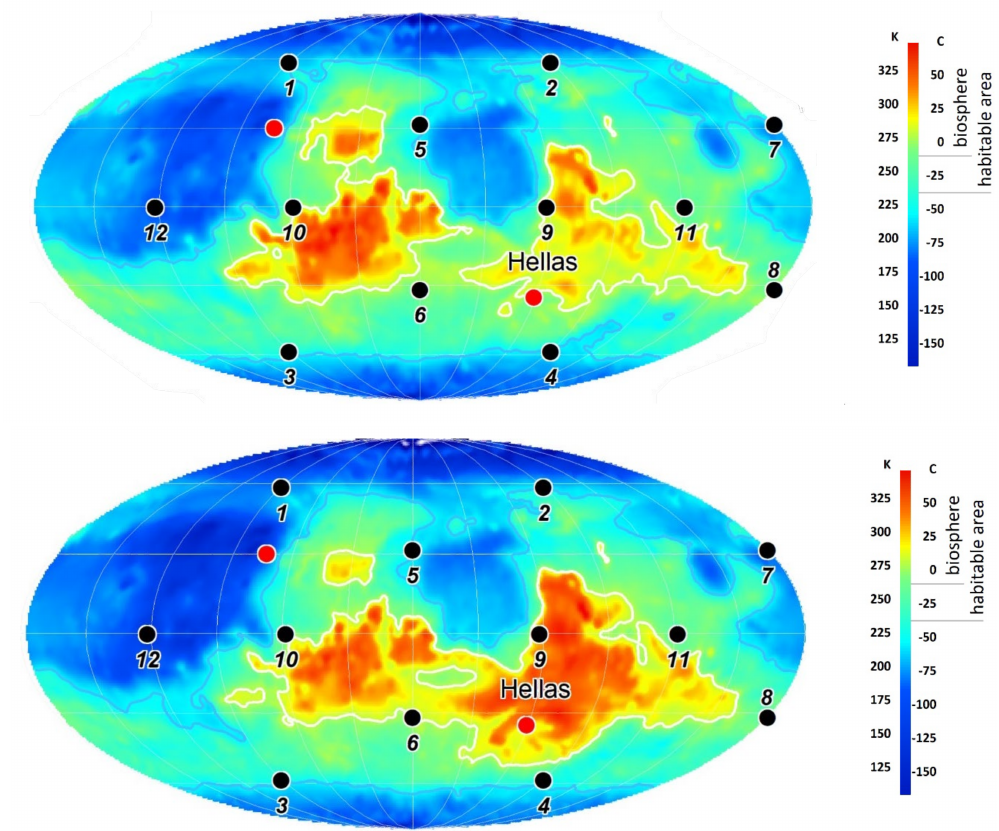
Figure 14. Hellas: 100 GT “asteroid” ( top ), 1.5 MT “factory” ( bottom ) (after 100 Martian